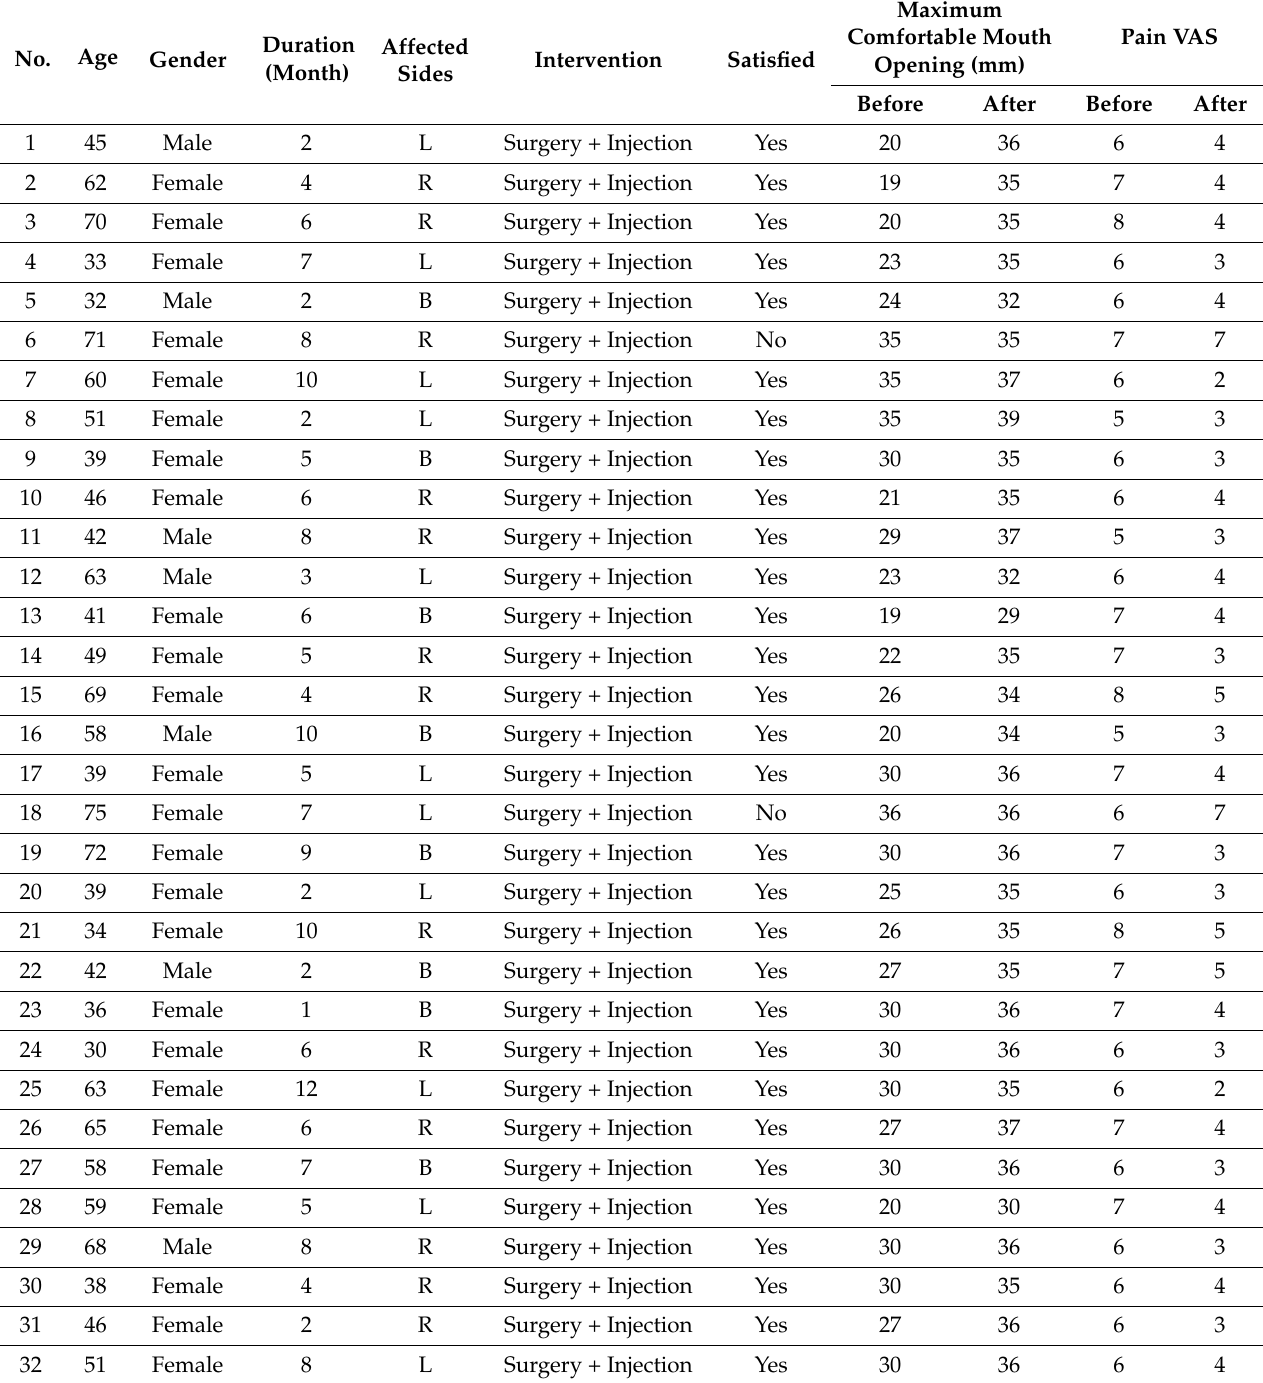
Table 1. Patient